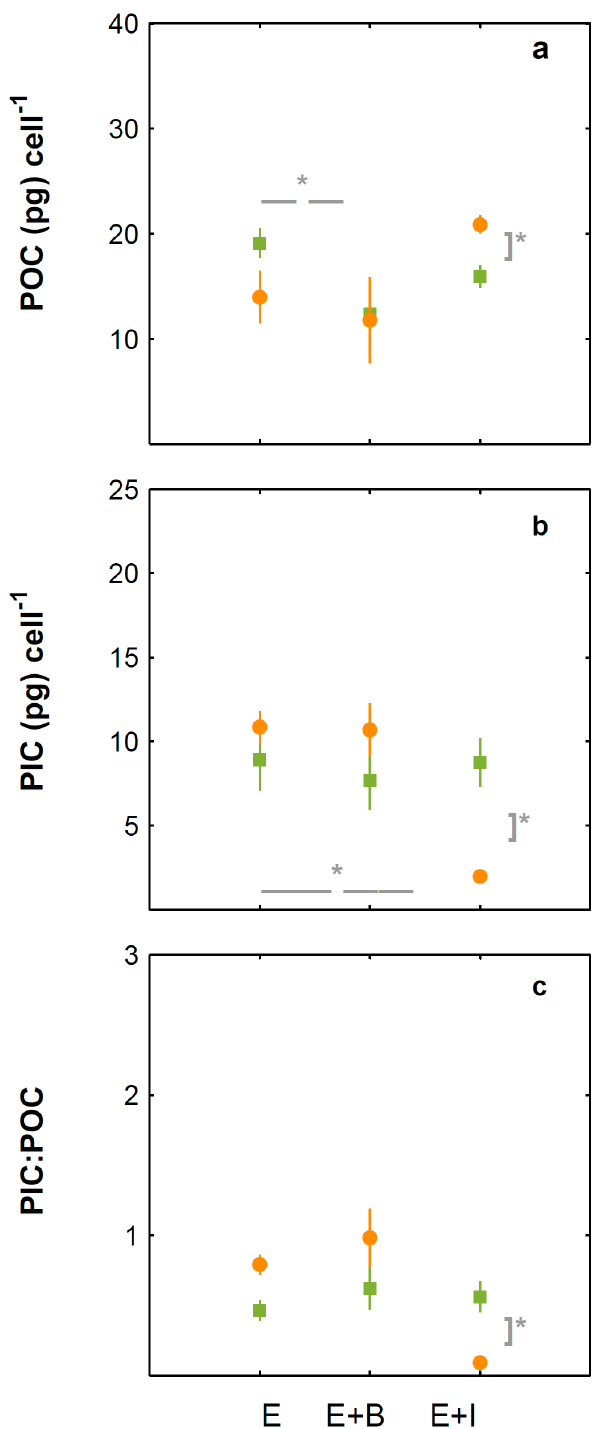
Figure 5. Cellular elemental quotas of E. huxleyi monocultures and E. huxleyi co-cultured with Brachybacterium sp. (E + B) and with I. abyssalis (E + I), under 475 (green) and 1056 µatm (orange). Particulate organic carbon ( a ), particulate inorganic carbon ( b ) and particulate inorganic to organic carbon ratio ( c ). * Denotes significant differences.